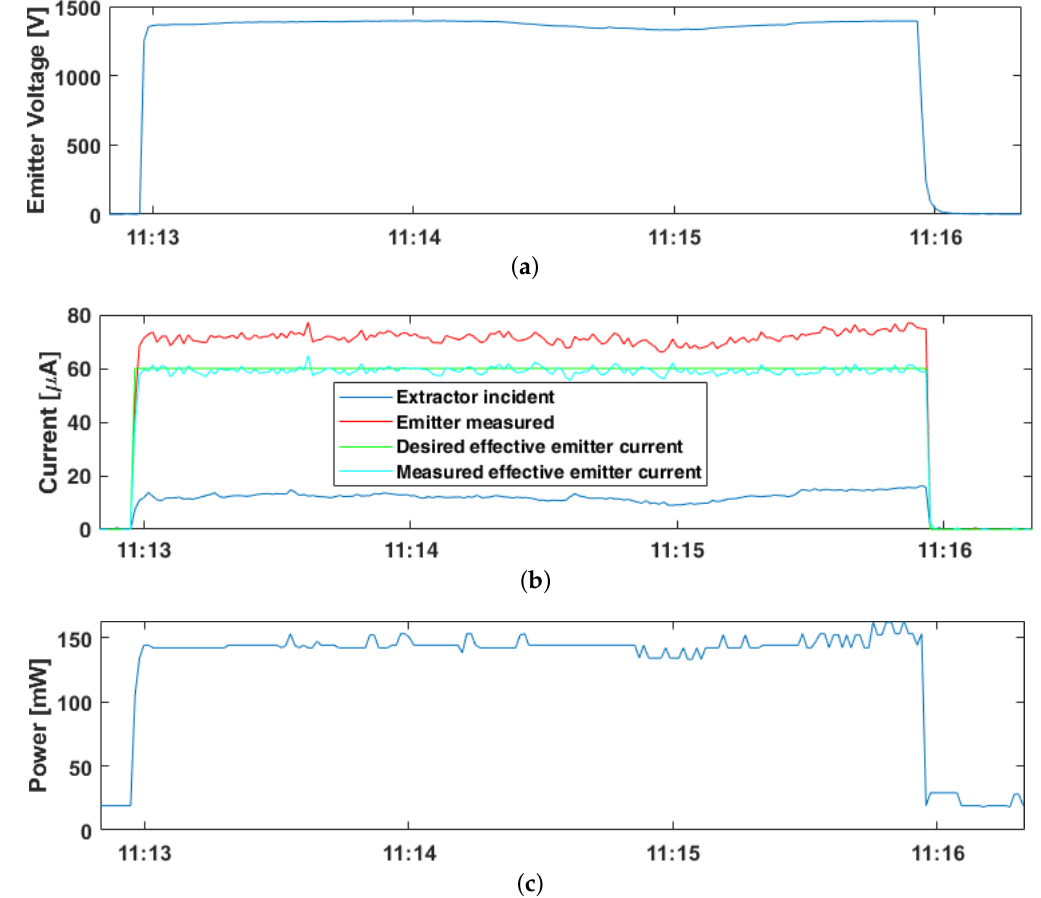
Figure 6. First in-orbit experiment of this CNT-based electron source on 21 February 2019. ( a ) Emitter voltage U mon of the neutralizer chip. ( b ) The monitored neutralizer currents of the PPU. ( c ) Power consumption of the neutralizer